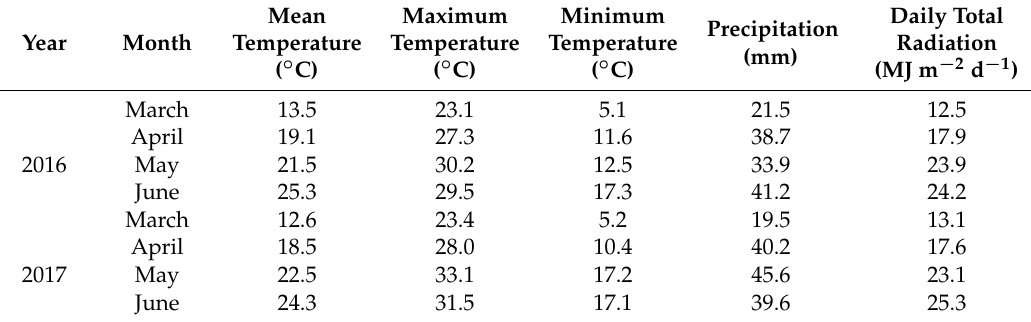
Table 1. Temperature, rainfall, and solar radiation at the experimental farm during the growing seasons of 2016 and